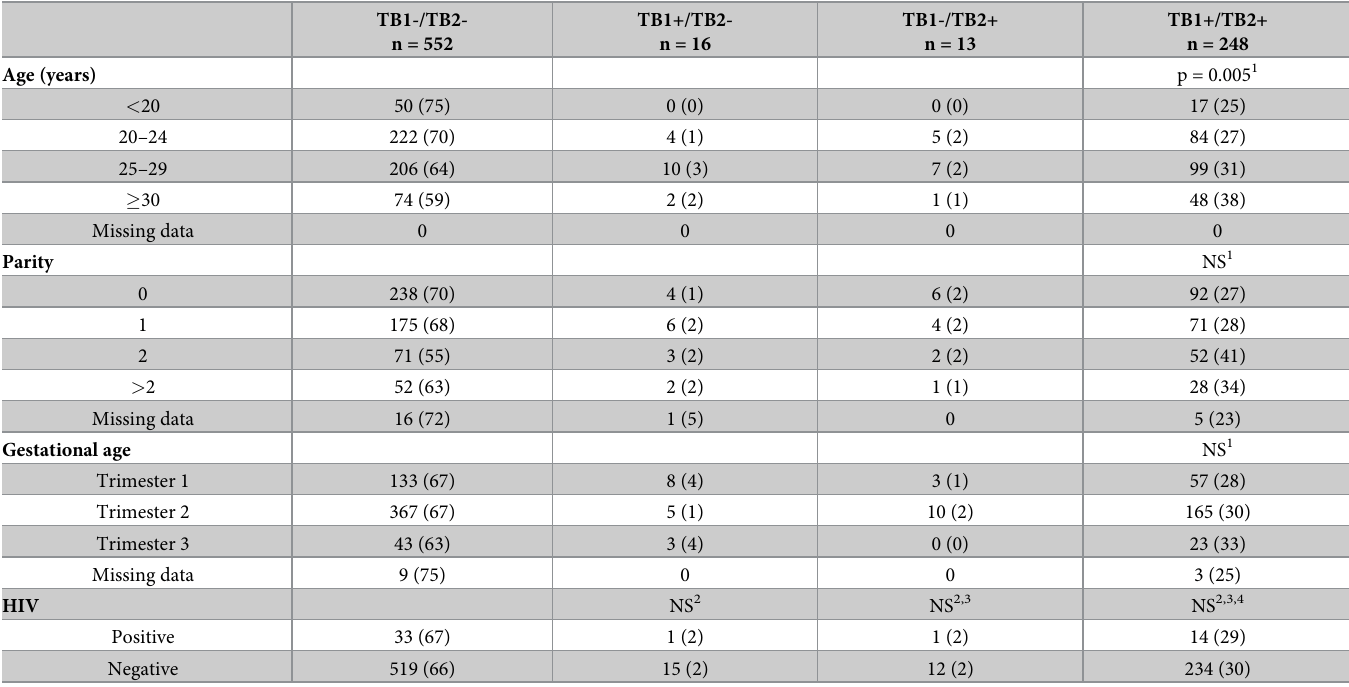
Table 2. Characteristics of QFT-Plus-negative, discordant and concordant positive women.